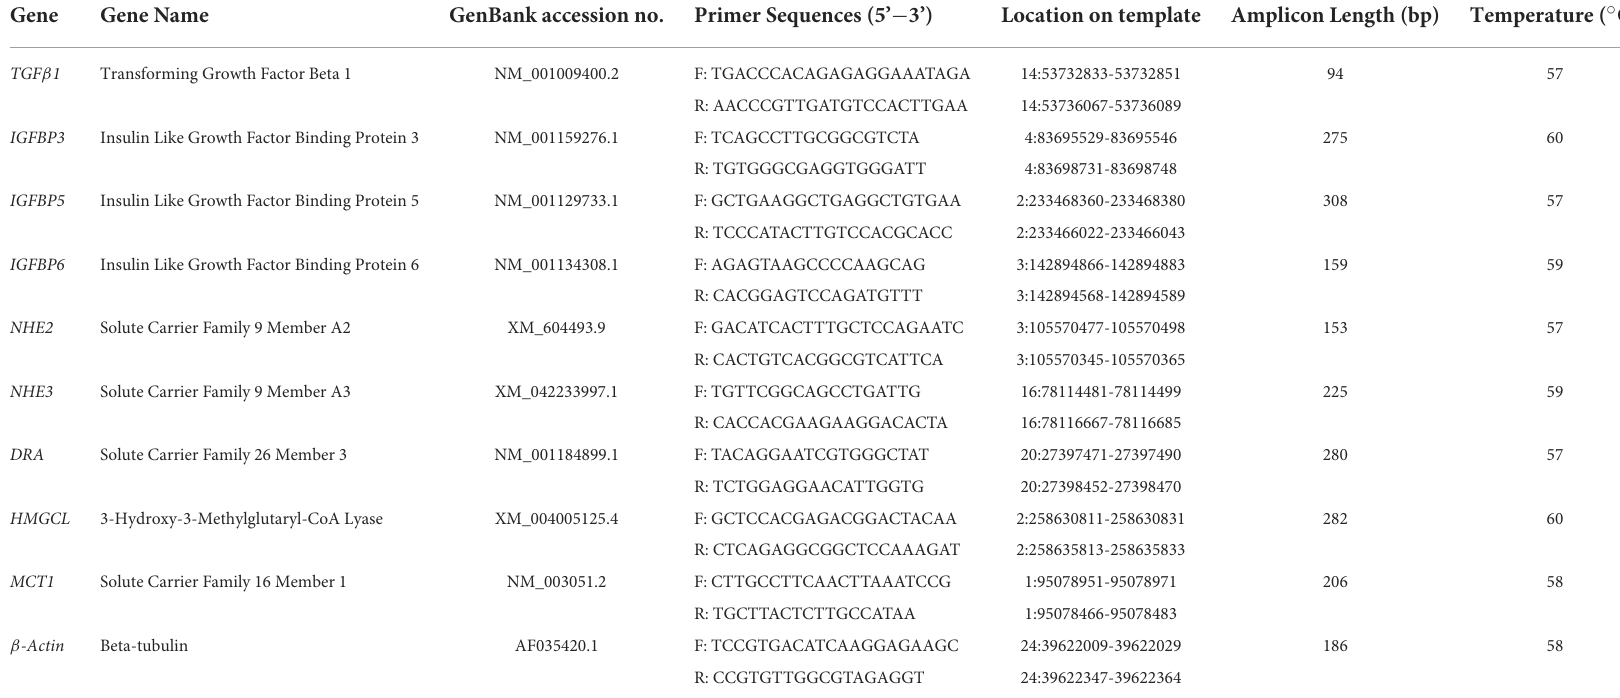
TABLE 2 QPCR Primers used in the validation of DEGs of rumen tissue between Hu lambs with different early feeding